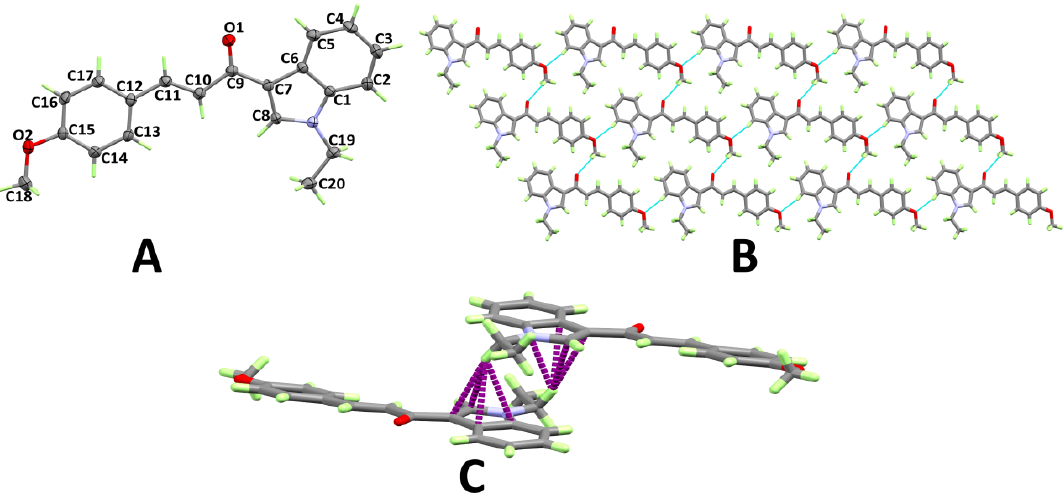
Figure 3. Atom numbering and thermal ellipsoids drawn at 30% probability ( A ), hydrogen bonds ( B ), and C–H··· π interactions ( C ) in 3c .